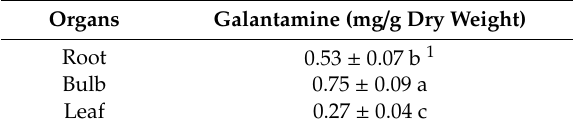
Table 2. Galantamine content in di ff erent organs of L. radiata grown in a growth chamber.